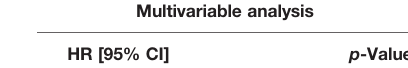
TABLE 3 | Univariate and multivariate Cox regression analyses of DFS of the AC patients in the training cohort.